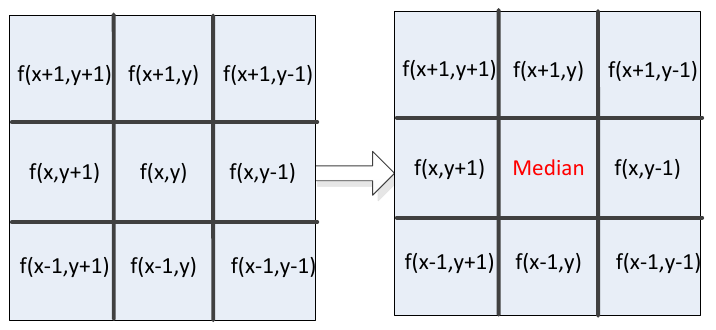
Figure 4. Median filtering diagram.